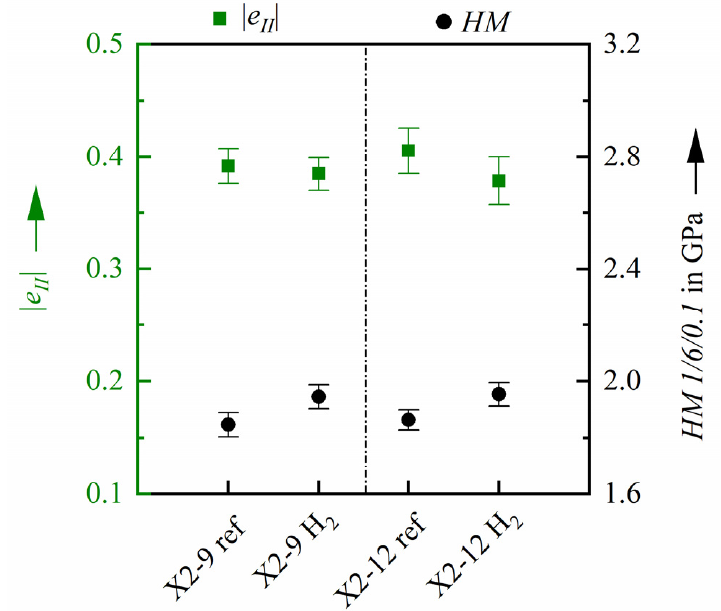
Figure 6. Comparison of the Martens hardness HM and the cyclic hardening exponent CHT e II of precharged (H 2 ) and reference (ref) specimens of the metastable austenitic steels X2-9 and X2-12 determined at F max = 1000 mN by means of the PhyBaL CHT method.